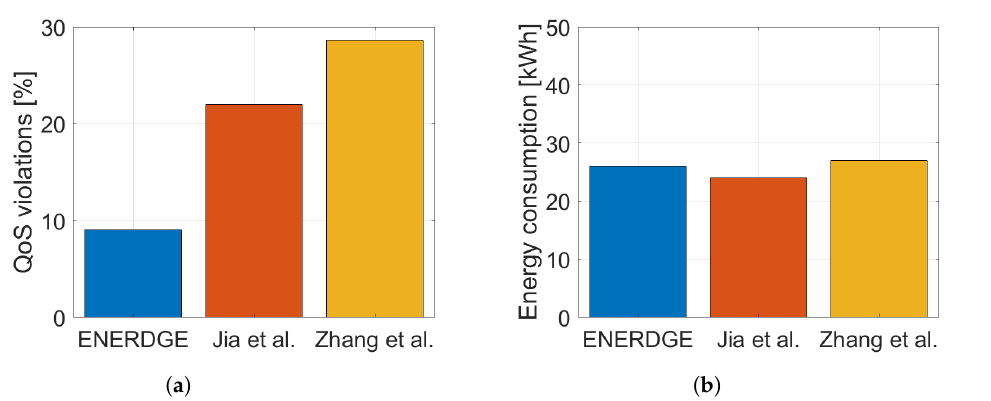
Figure 12. QoS violations and energy consumption during Experiment A. ( a ) QoS violations; ( b ) en- ergy consumption.